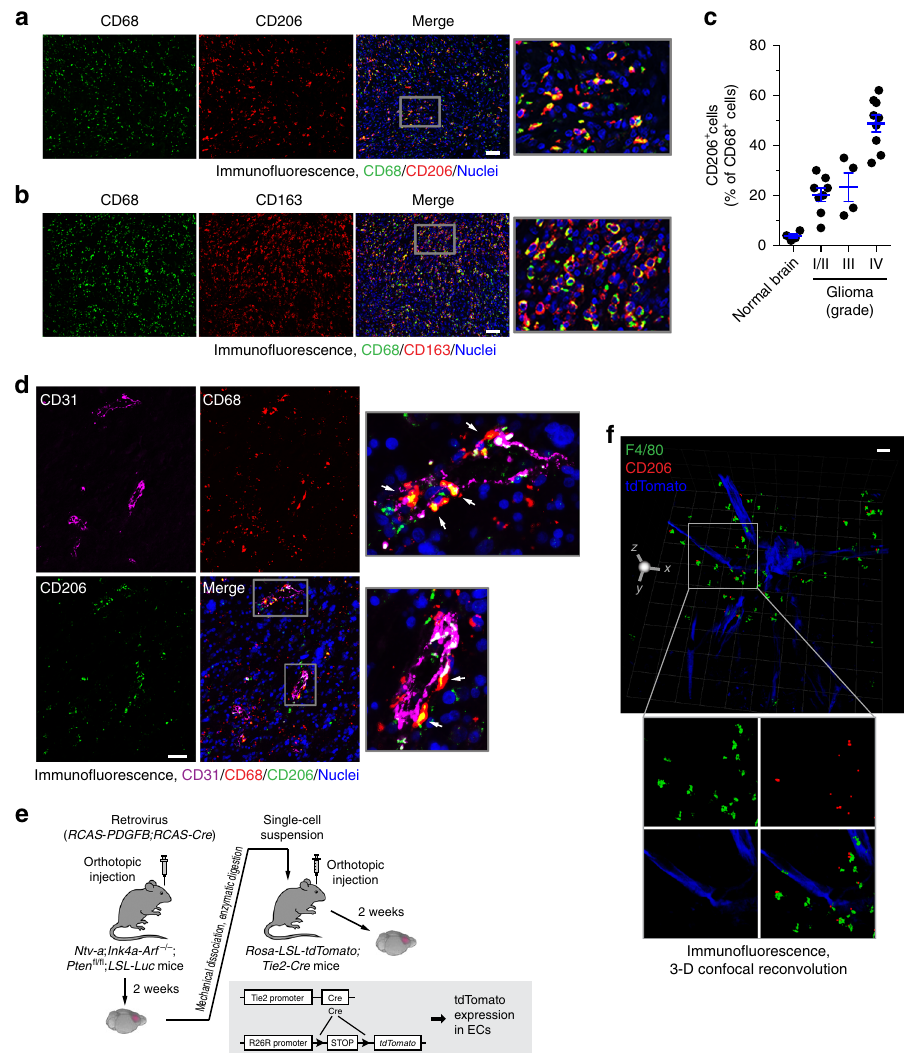
Fig. 1 Alternatively activated macrophages are localized proximately to GBM-associated ECs. a – d Tissue sections from human normal brain and surgical specimens of human glioma tumors were probed with different antibodies. a GBM tumor sections were stained with anti-CD68 and anti-CD206 antibodies. Representative images are shown ( n = 5 GBM patient tumors). Bar represents 100 μ m. Zoom-in factor: 4. b GBM tumor sections were stained with anti-CD68 and anti-CD163 antibodies. Representative images are shown ( n = 5 patient GBM tumors). Bar represents 100 μ m. Zoom-in factor: 4. c Normal brain and GBM tumor sections were stained with anti-CD68 and anti-CD206 antibodies. Quanti fi ed data are shown (total n = 4 normal brains and 21 glioma tumors, mean ± SEM). d GBM tumor sections were stained with anti-CD31, anti-CD206, and anti-CD68 antibodies. Representative images are shown ( n = 5 patient GBM tumors). Arrows indicate CD68 + CD206 + cells. Bar represents 100 μ m. Zoom-in factor: 4. e , f GBM was induced by RCAS- mediated gene transfer in Ntv-a;Ink4a-Arf − / − ; Pten fl / fl ; LSL-Luc mice, followed by orthotopic tumor transplantation into Rosa-LSL-tdTomato ; Tie2-Cre mice. e Experimental procedure. f Thick sections were stained with anti-F4/80 and anti-CD206 antibodies, and subjected to confocal scanning imaging. 3-D images were generated and shown. Bar represents 200 μ m. Zoom-in factor: